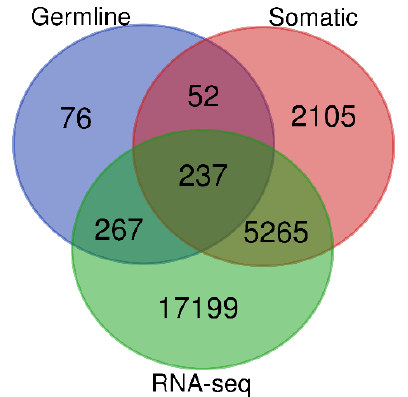
Figure 2. Distribution of somatic and germline-mutated and nonmutated genes significantly differentially (and not differentially) expressed between patients with TNBC and control samples. The blue circle represents genes containing germline mutations, green circle represents all significantly differentially expressed genes from RNA-Seq, and the pink circle represents all somatic-mutated genes. Table 1. List of the 34 gene signature containing the most highly somatic-mutated genes (>5 mutation events per gene) that were significantly differentially expressed between TNBC tumors and controls. Expression Gene Symbol Chromosome Position Number of mutation Events p -value TTN *